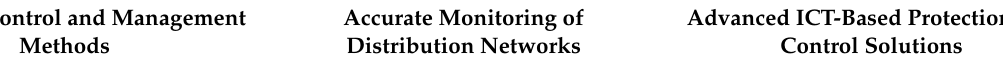
Table 2. The evolution of (10) adaptive control and management methods, (11) accurate monitoring of distribution networks, and (12) advanced ICT-based protection and control solutions during stages 1–3 (see Table 1 and Figure